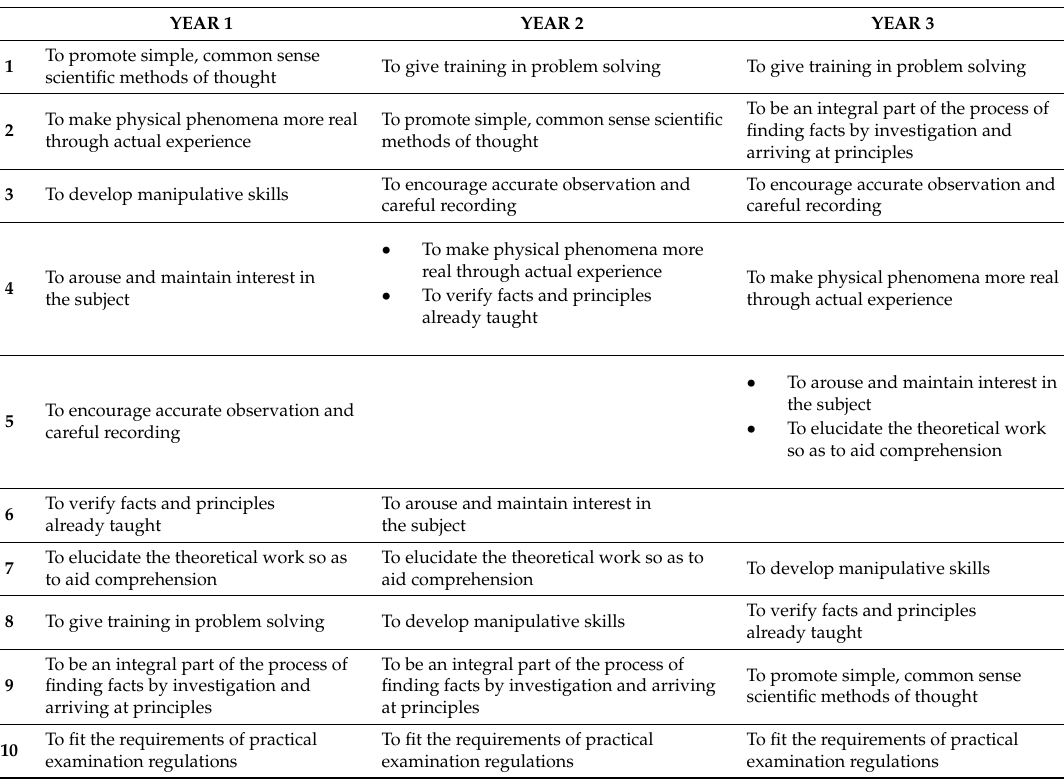
Table 1. Aims of practical work in undergraduate life sciences between years (Adopted by Kerr, 1963) [4].